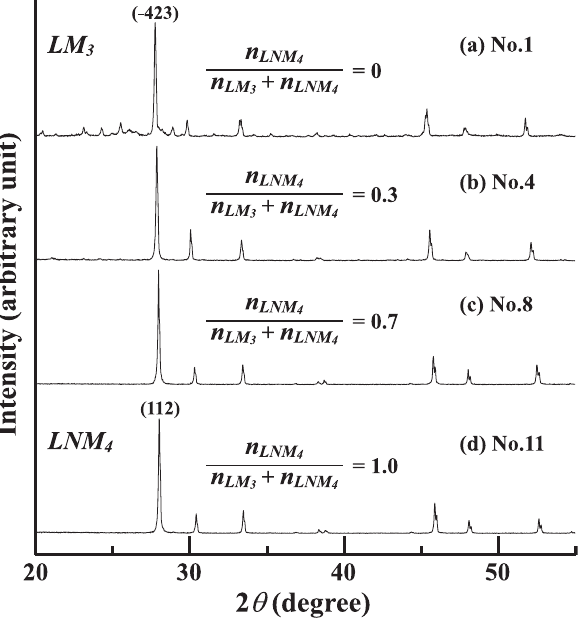
Fig. 2: X-ray diffraction patterns of samples 1 , 4 , 8 and 11 .